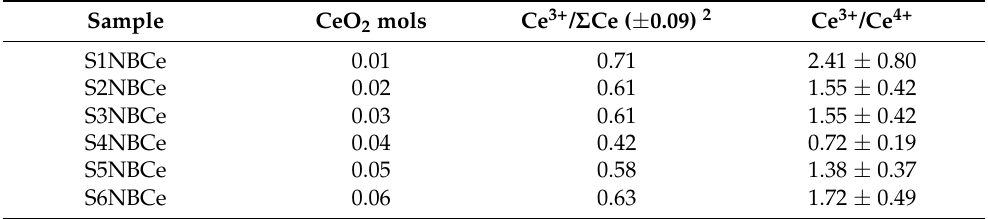
Table 2. The concentrations of Ce 3+ and Ce 3+ /Ce 4+ ratio within the processed glasses Na 2 O · 2B 2 O 3 1 melted with different amounts of CeO 2 .